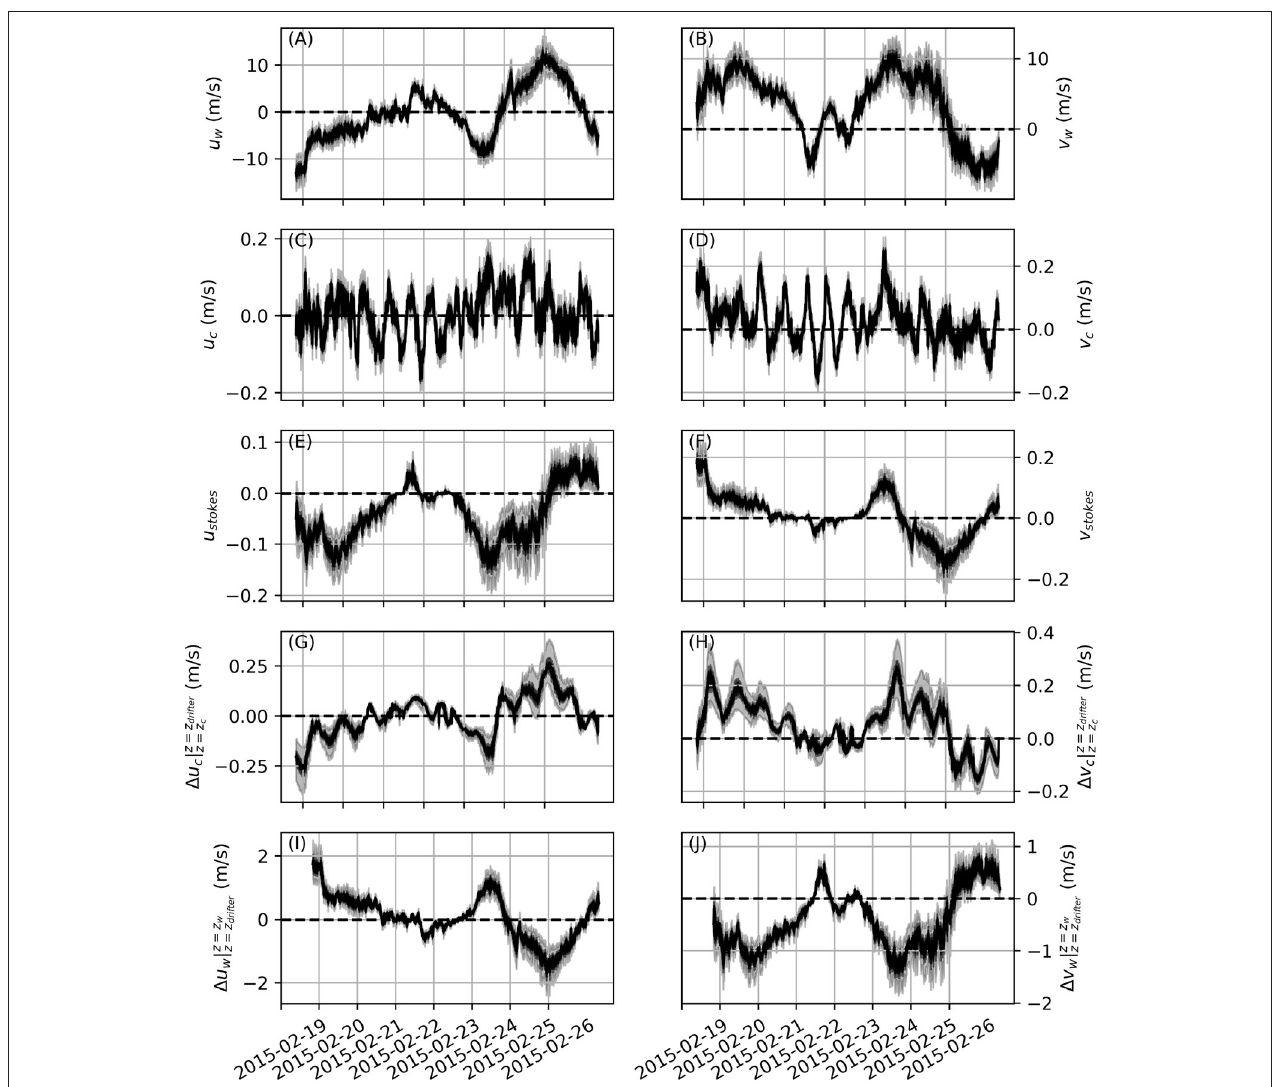
FIGURE 6 | Components of fuzzy wind (A,B) , current (C,D) , Stokes drift (E,F) , current shear (G,H) , and wind shear (I,J) for the first 7 days of the drifter deployment. The crisp value (measurement) is shown in black and the three fuzzy membership levels are indicated in grayscale. For clarity in (E–J) only values for SCT drifters with the velocity profile applied by the “centroid” scheme are